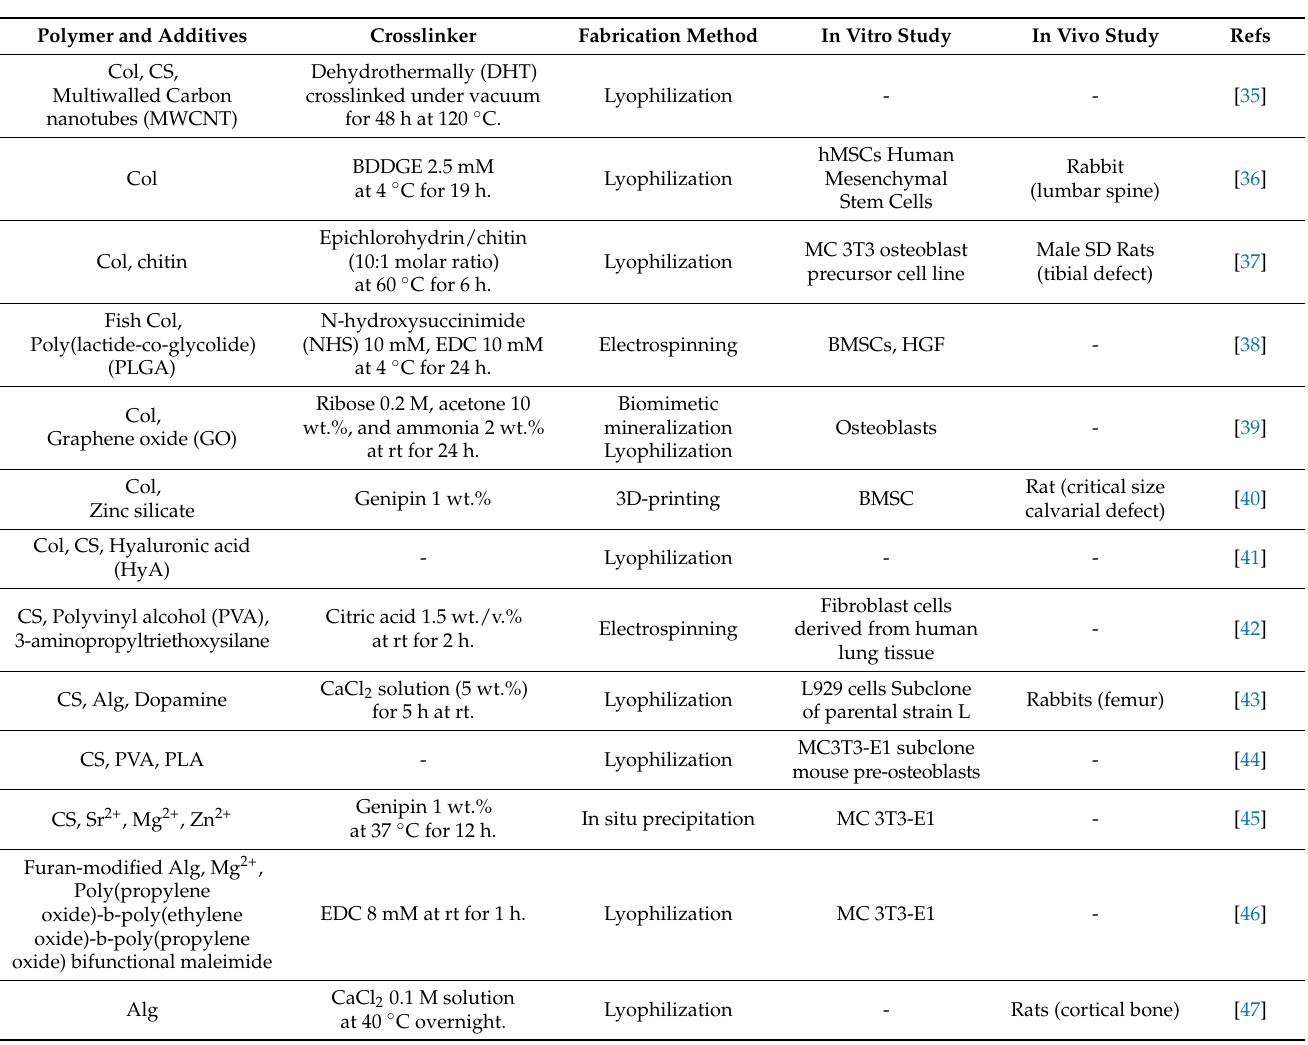
Table 2. Details of different natural polymers recently used in the preparation of hydroxyapatite biocomposite